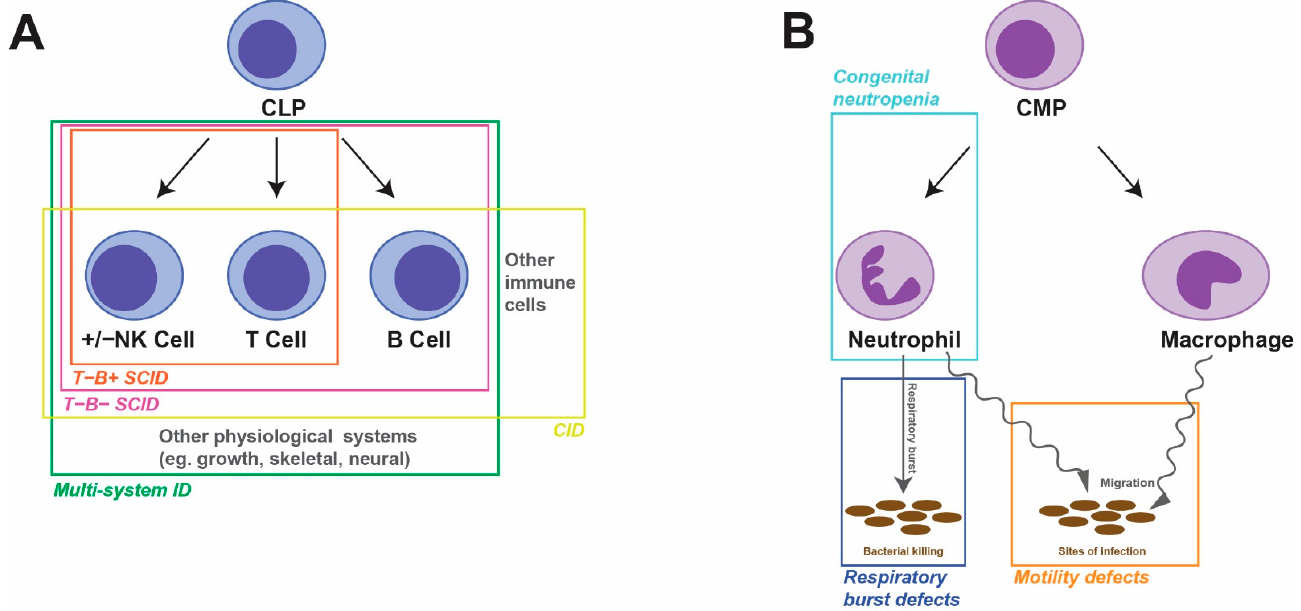
Figure 1. Overview of human PIDs. Schematic of lymphopoiesis ( A ) and myelopoiesis ( B ), indicating the cells, developmental pathways and activities impacted by the indicated PIDs.